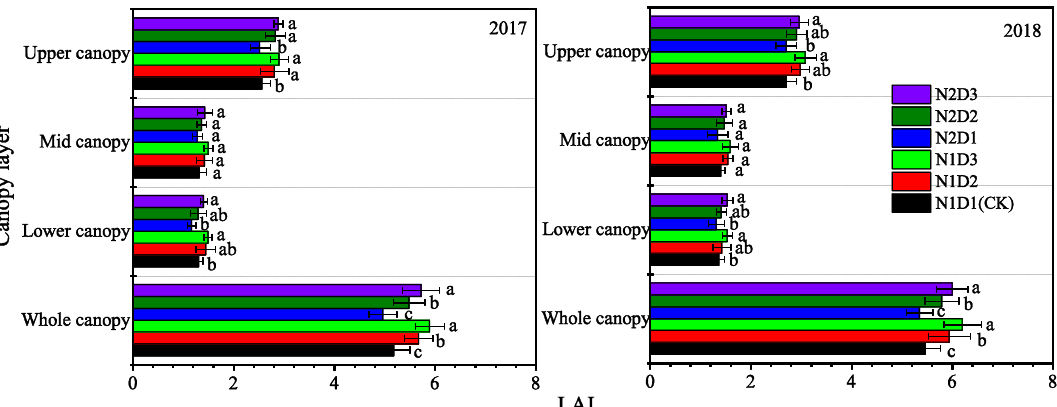
Figure 3. Vertical distribution of LAI in the canopy of maize in different planting treatments. The data were averaged measurements on 45 and 60 days after emergence (DAE), 2017 and 50 and 65 DAE, 2018. Upper canopy, middle canopy and lower canopy of maize mean top-two leaves above the ear leaf, the ear leaf and two leaves above and below it, and two leaves below the ear leaf-bottom leaf, respectively. Each data point is the mean ± S.E. of three replications. Values followed by different letters within a column are significantly different ( P < 0.05).